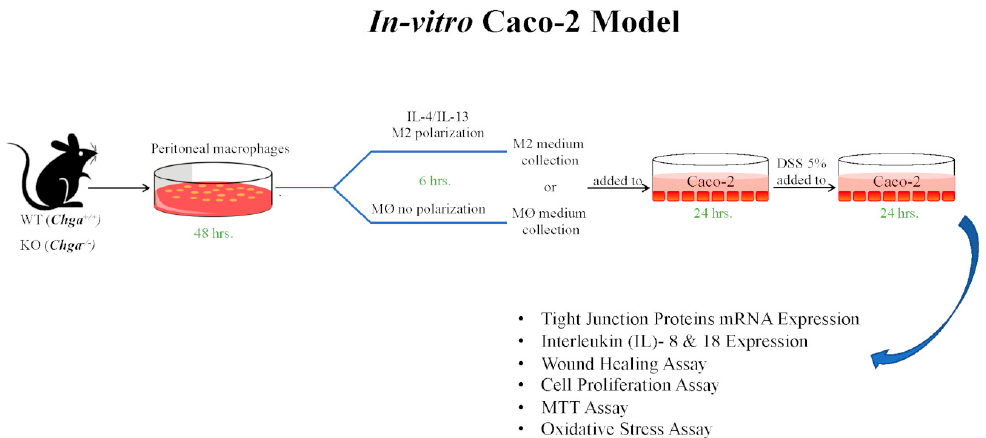
Figure 11. Experimental design: Caco-2 culture. Figure 11. E xperimental design: Caco-2 culture.